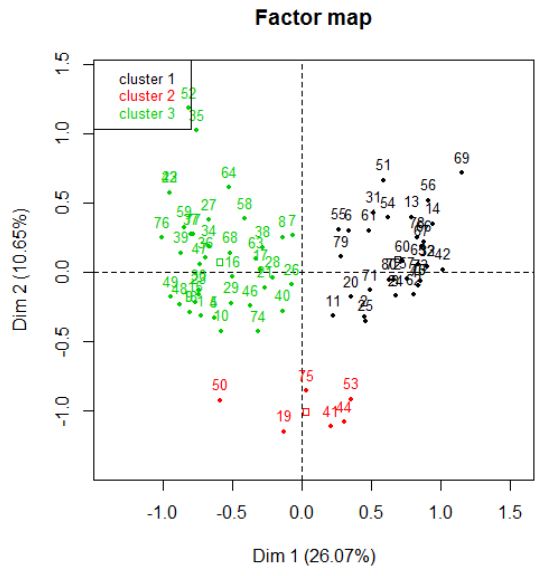
Table 5. Distribution of breeders in clusters for the most relevant